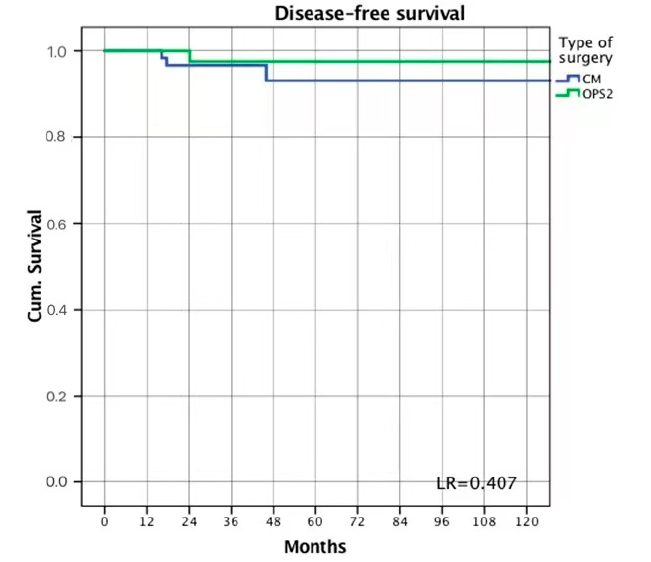
Figure 2. Disease-free survival.